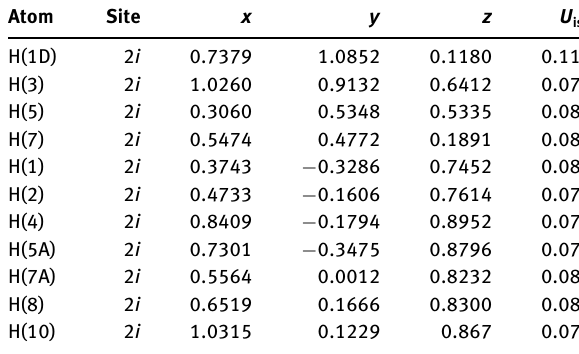
Table 2: Fractional atomic coordinates and isotropic or